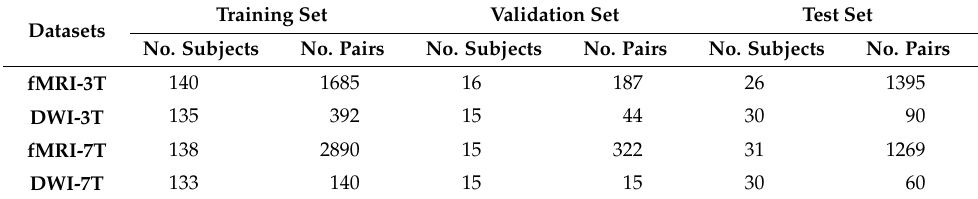
Table 2. A summary of the training, validation, and test sets for each of the four datasets.